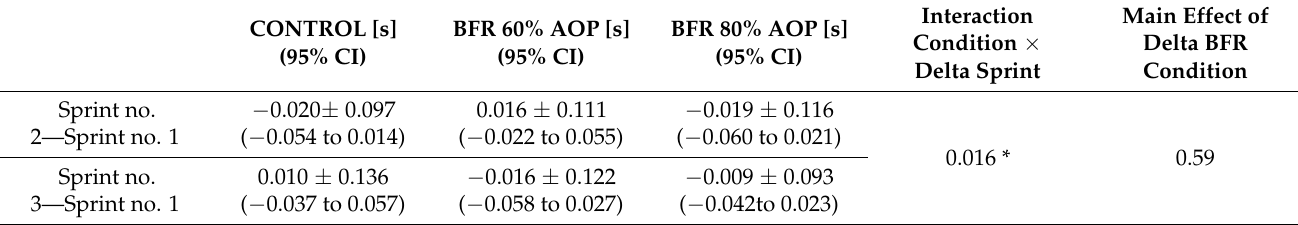
Table 3. A comparison between particular sets of sprint under control and BFR